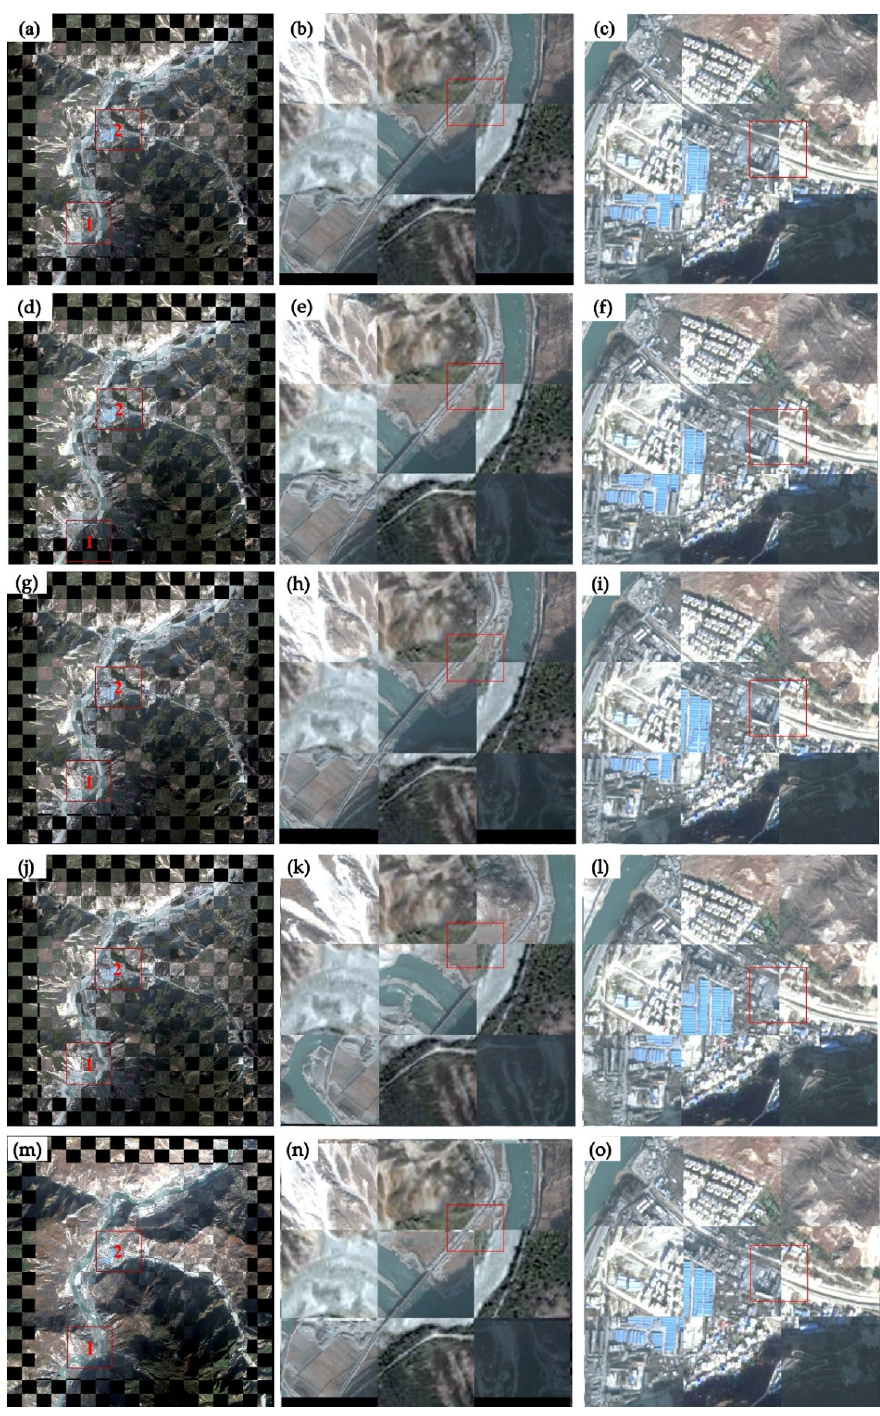
Figure 11. Checkerboard images for the P-C dataset. ( a ) Original image; ( b ) enlarged image of red box 1 in ( a ); ( c ) enlarged image of red box 2 in ( a ); ( d ) result for the proposed method; ( e ) enlarged image of red box 1 in ( d ); ( f ) enlarged image of red box 2 in ( d ); ( g ) result for the Patch-SIFT; ( h ) enlarged image of red box 1 in ( g ); ( i ) enlarged image of red box 2 in ( g ); ( j ) result for the SIFT; ( k ) enlarged image of red box 1 in ( j ); ( l ) enlarged image of red box 2 in ( j ); and ( m ) result for the SURF; ( n ) en- larged image of red box 1 in ( m ); ( o ) enlarged image of red box 2 in ( m ). The red boxes indicate the regions where noticeable differences can be observed.